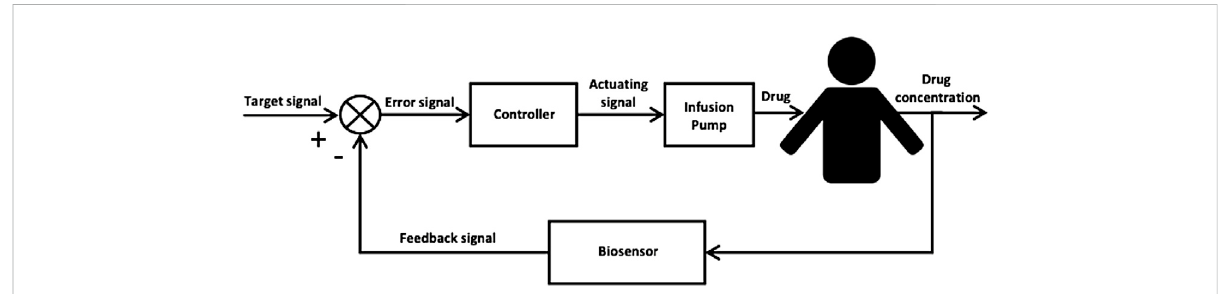
FIGURE 1 Block diagram of a closed-loop control system for automated, precision drug delivery incorporating a biosensor, a feedback controller and an infusionpumpfordrug deliverto thepatient.Thebiosensorprovidesreal-time invivo measurementsofthepatient ’ sdrug concentrationlevel which isthencomparedtoaprede fi nedtargetsignal(set-point)toproduceanerrorsignalthatisfedtothefeedbackcontroller.Thefeedbackcontrollerby its design computes a corrective action to reduce the error signal and sends an actuating signal to the infusion pump which delivers the corresponding drug dose to the patient.